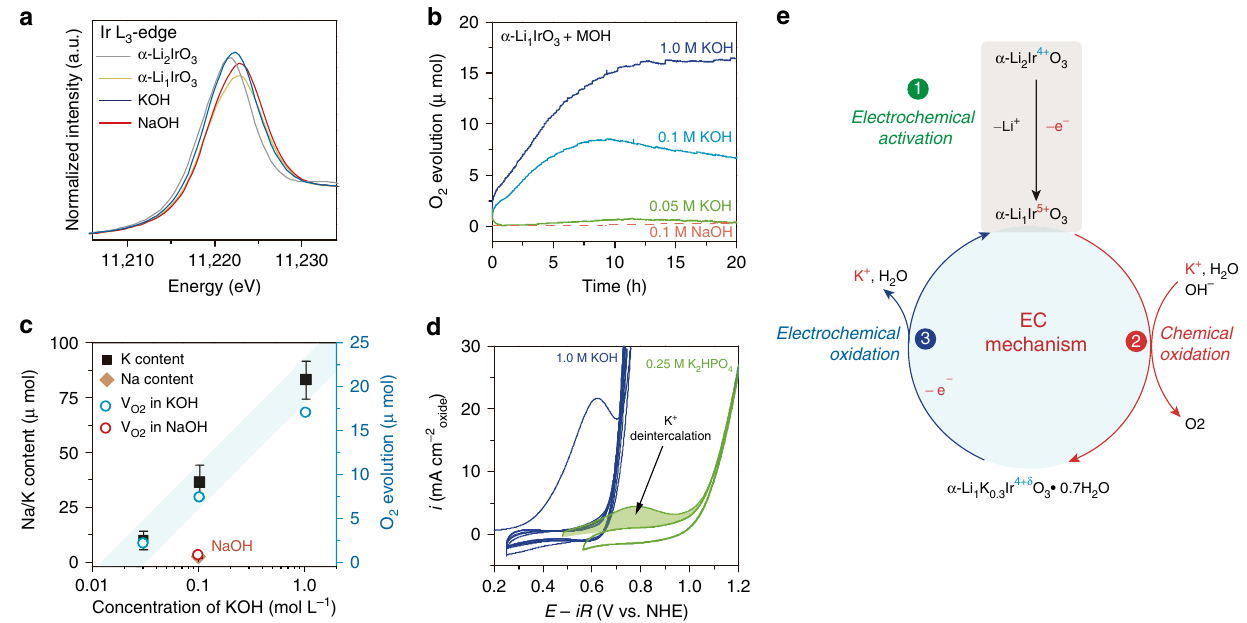
Fig. 4 Chemical oxidation of water during birnessite formation. a Ir L 3 -edge XAS spectra probing the reduction of Ir after chemical reaction with KOH. b O 2 gas evolution as detected by online mass spectrometry when soaking α -Li 1 IrO 3 in KOH and NaOH solutions with increasing concentrations. c Linear relationship between the amount of intercalated K + ions in the birnessite phase (as deduced by EDX) and the O 2 gas evolution (as deduced from MS). d OER measurements in KOH at pH 14 compared to K 2 HPO 4 at pH 9 demonstrating the K + deintercalation from the birnessite phase at the OER potential. e Proposed EC mechanism for α -Li 2 IrO 3 , involving the electrochemical formation of a high valence α -Li 1 IrO 3 oxide ( E step), followed by the chemically oxidation of water to generate O 2(g) assisted by K + intercalation into the birnessite structure ( C